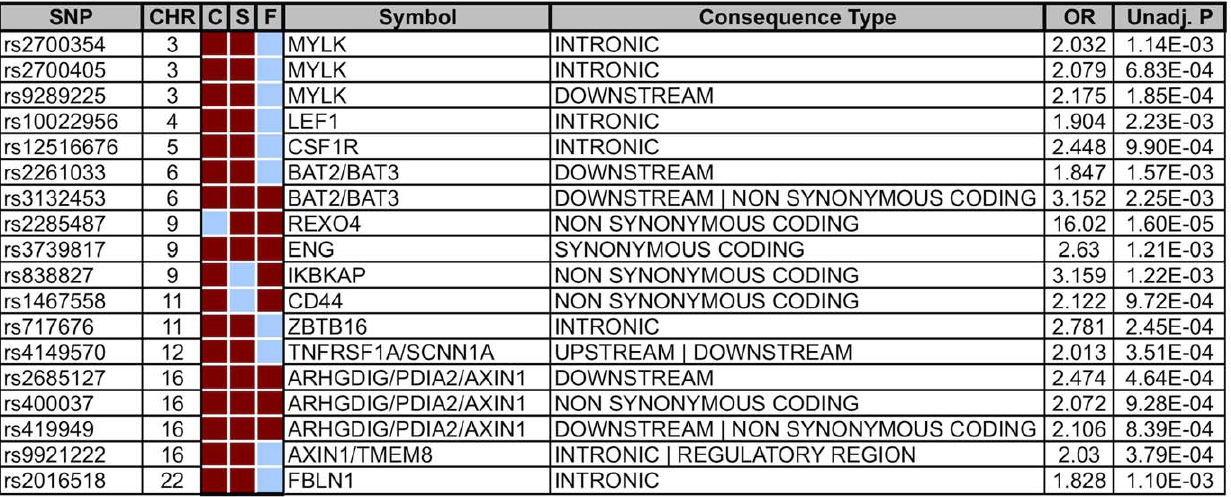
Figure 2. Frequent Placement in Top 100 uncorrected p-Values sorted by chromosome; SNPs appearing two or more times amongst the three categories. C=CANDID, S=STRING, F=fitSNP . Red=present in top 100, blue=not present in top 100. Remaining fields are Gene symbol , Ensembl-51 consequence type , O dds R atio, and unadjusted p-Value for each reported SNP.